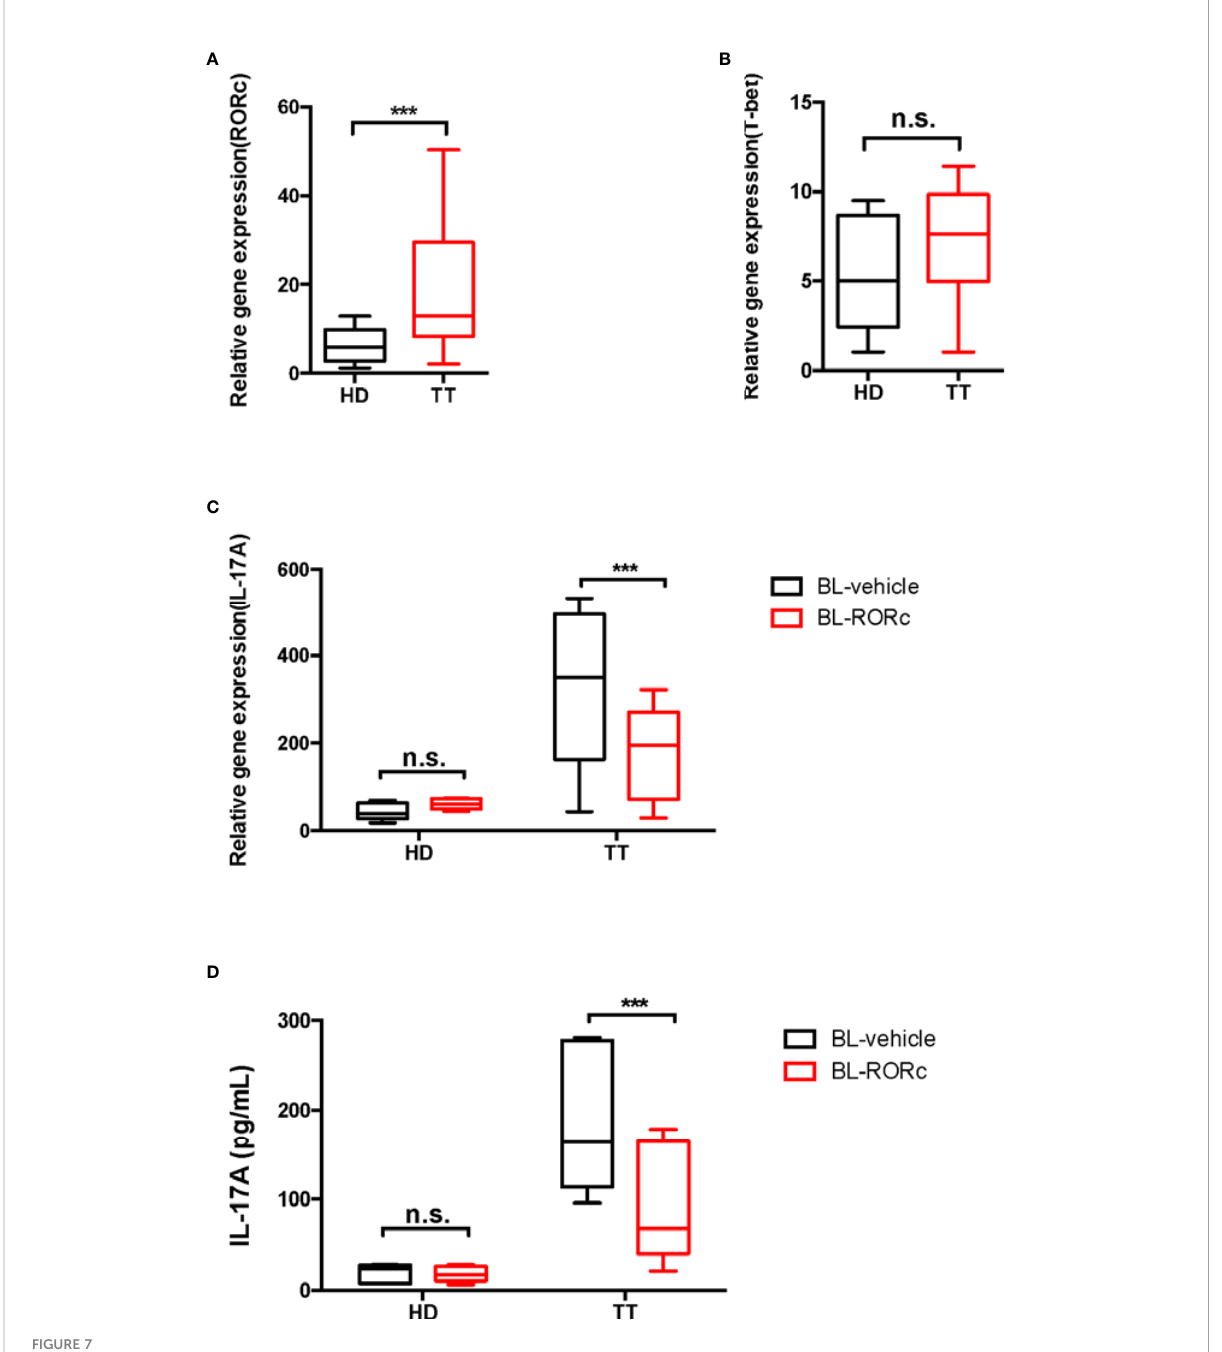
FIGURE 7 ROR g t gene silencing suppressed the production of dermal gd T cells in leprosy lesions. mRNA expression level of RORc (A) and T-bet (B) in dermal gd T cells were determined by qPCR. Relative gene expression indicated gene normalized for b - actin. (C) qPCR was performed to measure the transcript levels of Il17a in BL-RORc △ or BL-vehicle dermal gd T cells. (D) ELISA was performed to measure the secretion of IL-17A in BL-RORc △ or BL-vehicle dermal gd T cells. Data were shown as mean ± SEM. Statistical analysis was performed by t -test or two-way ANOVA. n.s.: no signi fi cance; *** p <